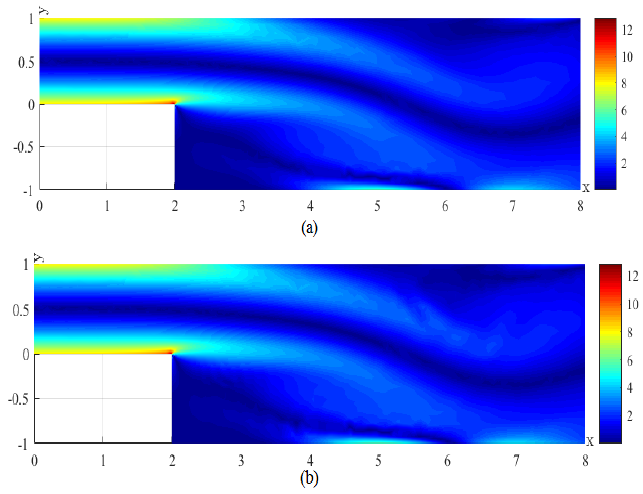
Figure 9. ( a ) The CNMFE solution for p at t = 6. ( b ) The RDRCNMFE solution for p at t = 6.